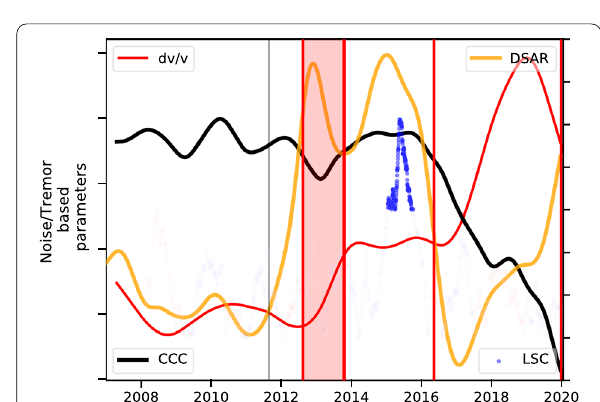
Fig. 9 Summarizing figure. The upper figure shows the seismic noise and tremor-related parameters compared with deformation proxies (lower panel). The DSAR, CCC and dv/v data have been smoothed with a Hendrick Prescott filter, which prevents temporal aliasing (parameters of 10 8 , 10 8 ,5*10 8